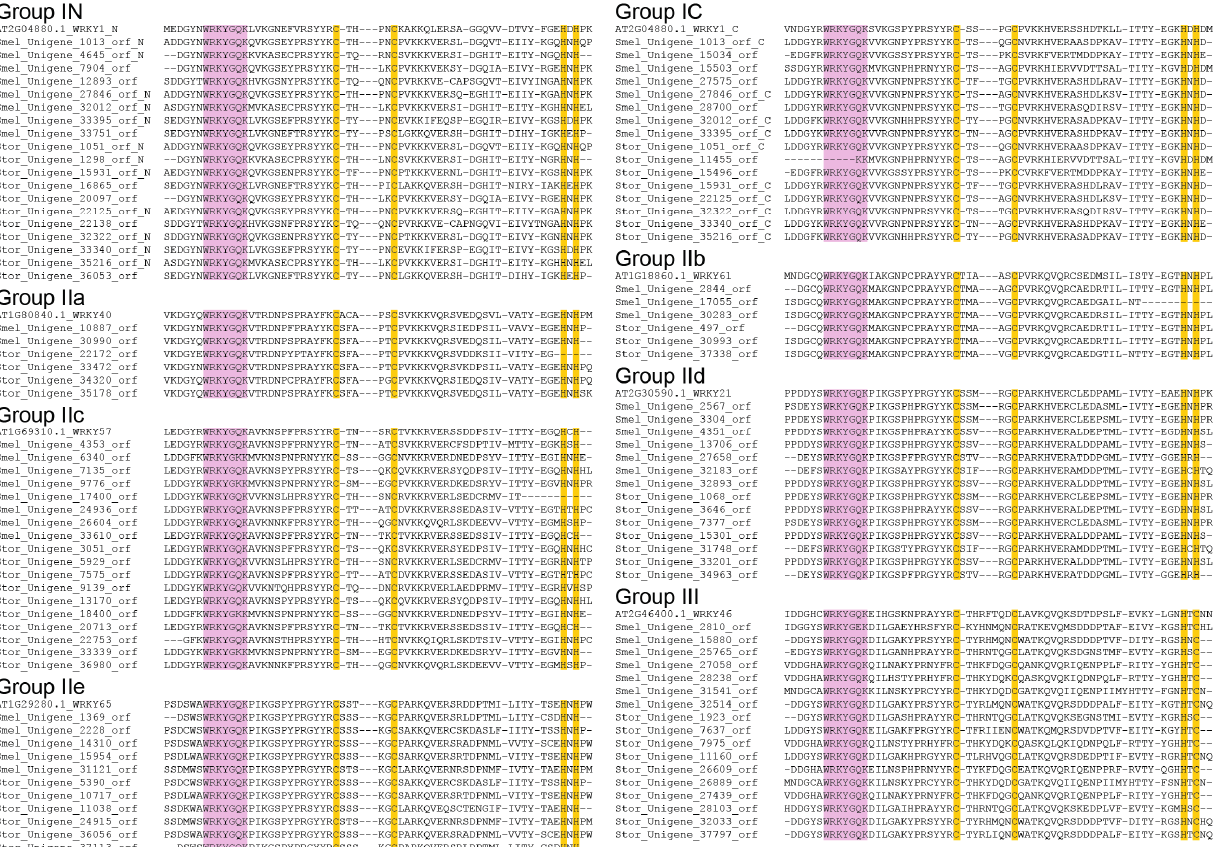
Figure 2. Multiple sequence alignment of the WRKY domains from eggplant and turkey berry WRKY genes. The suffixes “_N” and “_C” indicate the N - and C -terminal WRKY domain, respectively, of a specific WRKY gene from Group I. Alignment was performed using MEGA 6 [41]. Light purple indicates conserved WRKY amino acid domains, and orange indicates zinc-finger